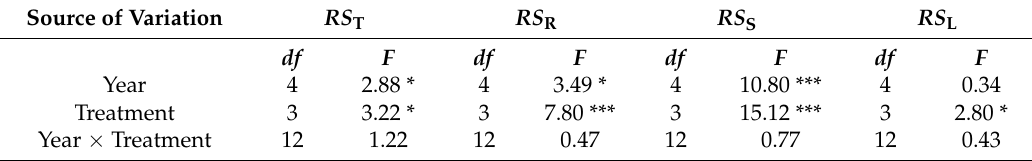
Figure 1. Inter-annual dynamics of soil respiration and its components under different N levels in the Pinus tabulaeformis forest. ( a – c ) represent intact, no litter, and no root and litter, respectively. Table 3. F -values of repeated-measures ANOVA for soil respiration RS T , RS S , RS L , and RS R from 2011 to 2015. RS T , total soil respiration; RS S , RS L , and RS R represent the soil respiration components derived from root removal soil, litter layer, and plant root, respectively. * p < 0.05; *** p <